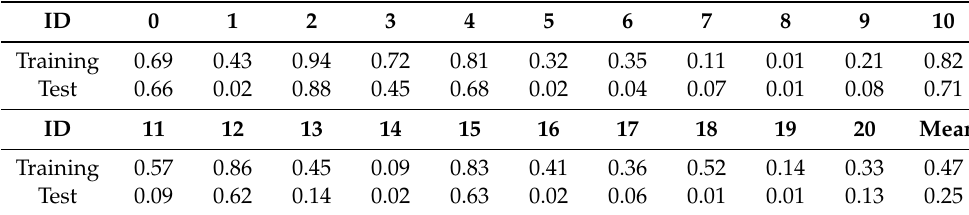
Table 15. IoU scores for Cityscapes in Experiment C.